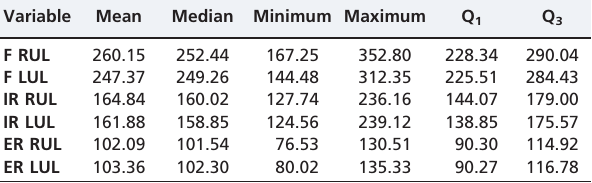
Table 1 - Results of the tests: Flexion of the right upper limb (F RUL), flexion of the left upper limb (F LUL), Internal Rotation of the right upper limb (IR RUL), Internal Rotation of the left upper limb (IR LUL) External rotation of the right upper limb (ER RUL) and external rotation of the left upper limb (ER LUL). Q 1 = first quartile; Q 3 = third quartile. Variable